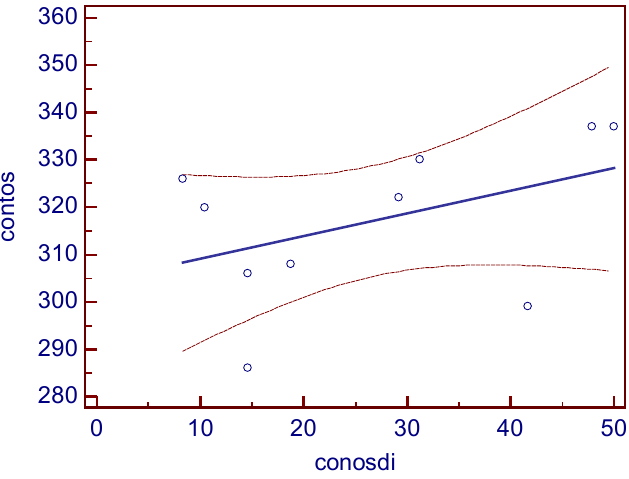
Figure 3 . Tear osmolarity (contos) versus OSDI score (conosdi) data (for the ten contact lens wearers in this sample) is represented in this scatter plot. Included is the linear regression line (solid blue line) with its associated 95% confidence interval (dotted red line), ( r = 0.45 p =